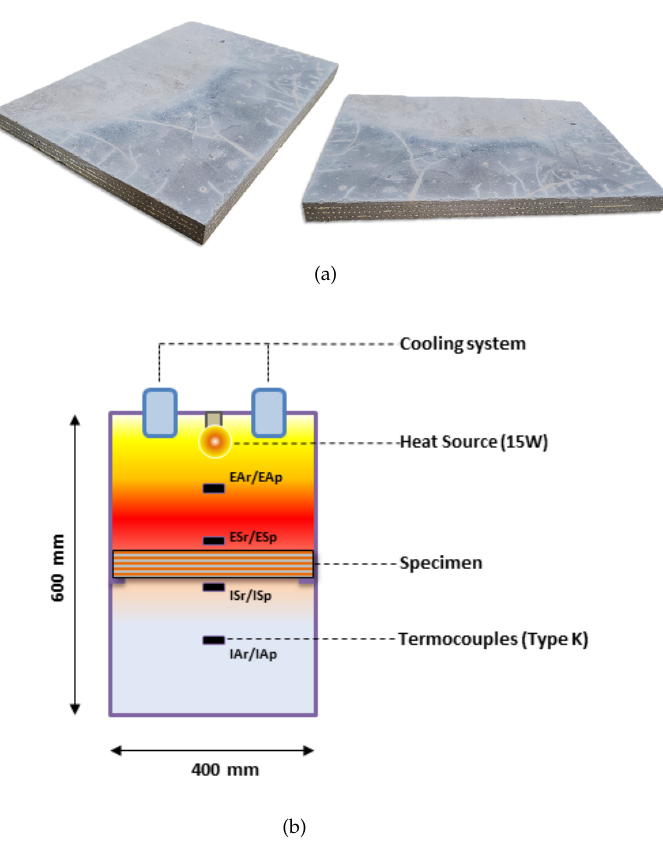
Figure 6. Thermal behavior test: ( a ) composite specimens and ( b ) test